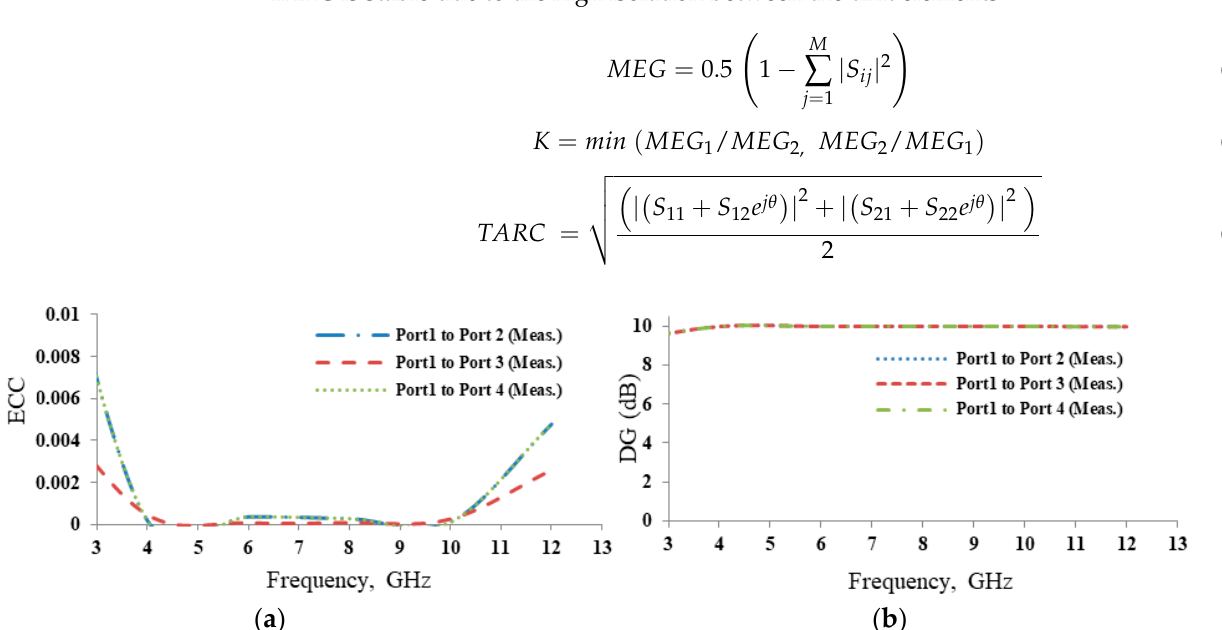
Figure 9. Performance of the proposed UWB MIMO antenna ( a ) Envelope Correlation Coefficient (ECC) ( b ) Diversity Gain (DG).